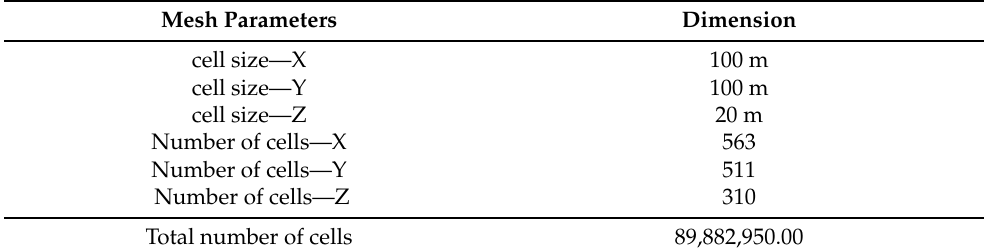
Table 2. Mesh used in the MR3D finite-difference forward- modeling exercise.